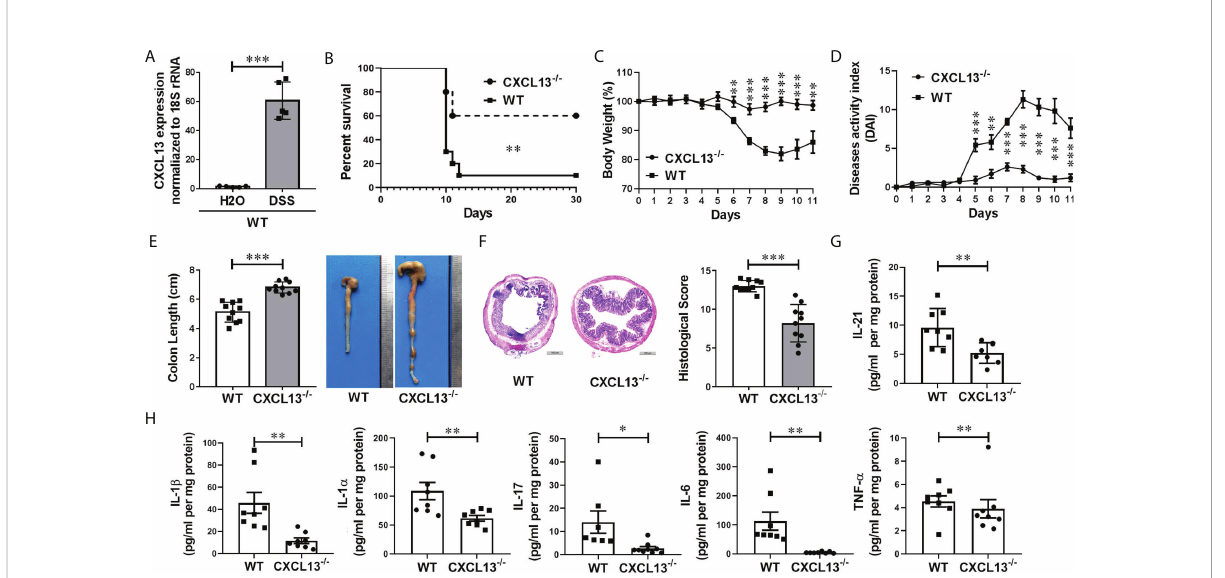
FIGURE 3 CXCL13 de fi ciency inhibits the occurrence and development of DSS-induced colitis. (A) Real-time PCR analysis of CXCL13 mRNA level in colon tissue of colitis and healthy mice (n=5/group). (B) Survival curve of WT and Cxcl13 -/- mice treated with 3.5% DSS drinking water for 7 days and then fed with regular drinking water for the rest of time (n=10/group). (C – F) Body weight changes (C) , diseases activity index (D) , colon lengths (E) , H&E-stained colon sections and histology scores (F) of WT and Cxcl13 -/- mice treated with 3.5% DSS drinking water for 5 days and then fed with regular drinking water for 6 days (n=10/group). (G, H) ELISA and Luminex analysis of tissue cytokines on day 11 of WT or Cxcl13 -/ mice treated with 3.5% DSS drinking water for 5 days and then fed with regular drinking water for 6 days (n=8/group). These results suggest that CXCL13 de fi ciency can effectively alleviate the severity of DSS-induced colitis, including improved survival, relieved weight loss and disease activity, and an effective reduction in in fl ammatory in fi ltration at the site of in fl ammatory the colon. Summary data are presented as mean ± SEM based on multiple mice, with P values determined by Kaplan-Meier analyses with the log-rank Mantel-Cox test (B) , or two-tailed Student ’ s t test (C – H) . * P < 0.05; ** P < 0.01; *** P <